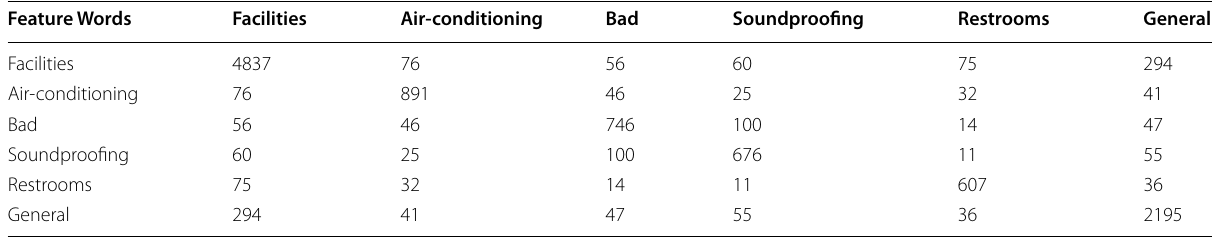
Note: This table is based on the data of the “general facilities” theme feature of 4-star hotels